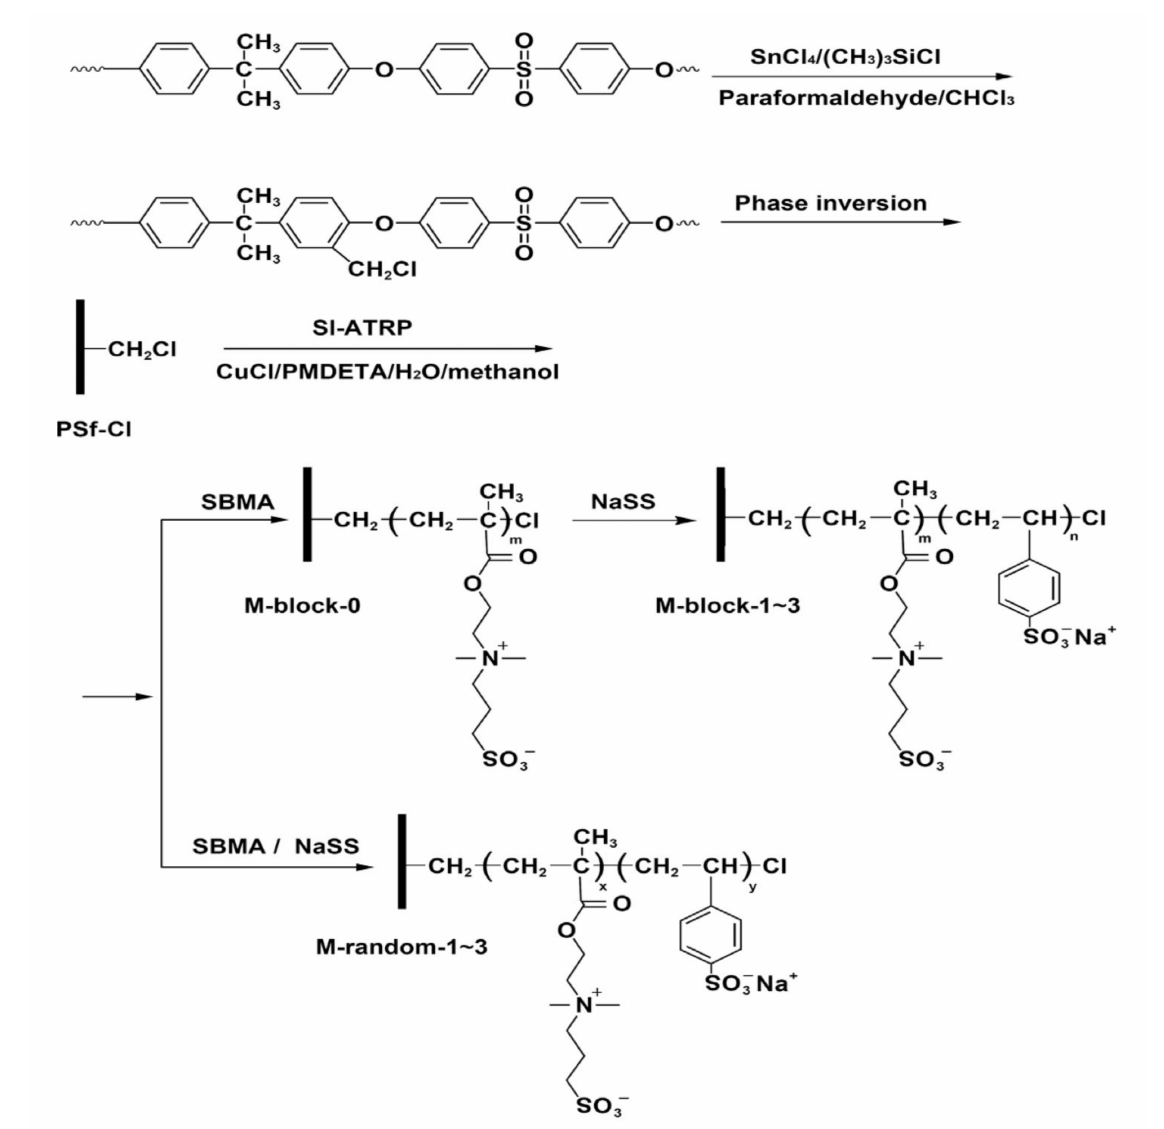
Figure 7. The preparation of PSF—Cl membrane, and P(SBMA-b-NaSS) and P(SBMA-co-NaSS) grafted membranes (reproduced with permission after